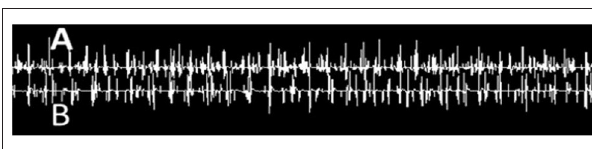
FIGURE 2 | Needle EMG recording of simultaneous co-activation of agonist–antagonist muscle pair using a concentric needle electrode and two-channel recording from (A) tibialis anterior and (B) gastrocnemius muscles.